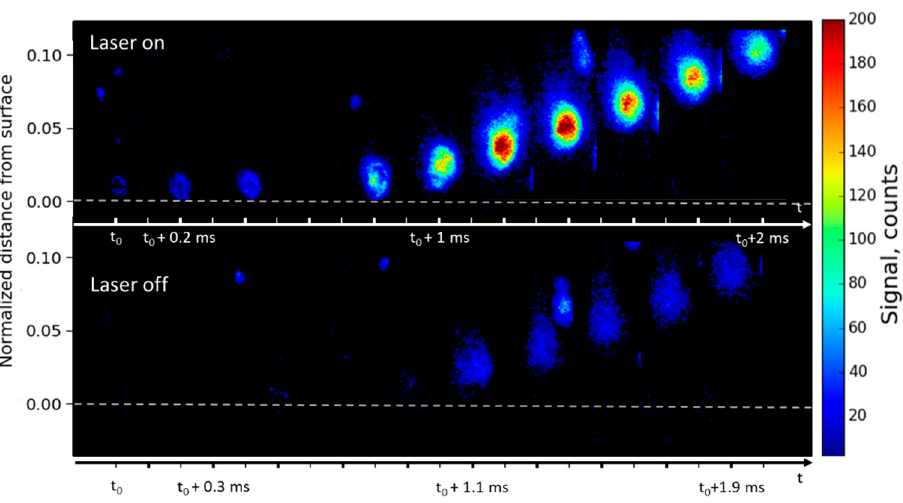
Figure 10. Sequence of eleven LIF images (top) and of ten emission images (bottom) just above the propellant surface. The distance from surface is normalized to the total flame height. The time delay between successive images is 0.1 ms. Images are recorded during the combustion of a burning Al / AP / HTPB propellant sample at 1.0 MPa. The propellant surface is indicated by a dashed line. The dynamic of the signal is 0–200 counts.